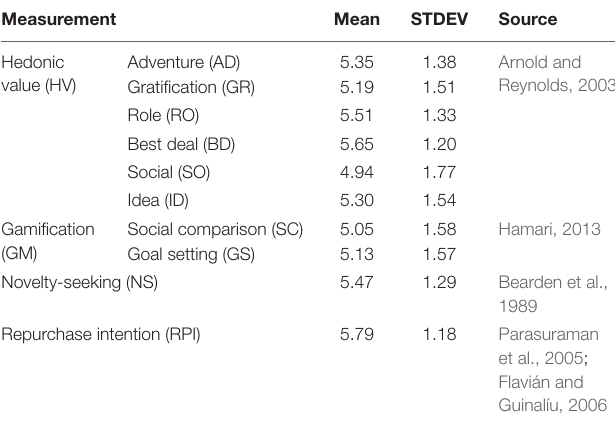
TABLE 3 | Constructs and related literature.